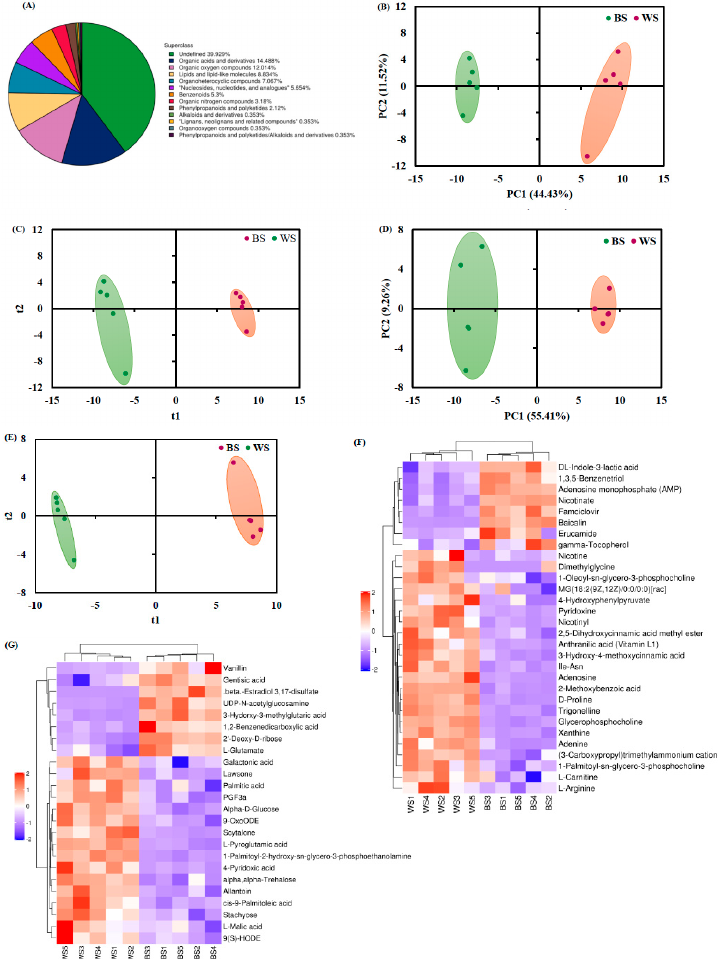
Figure 4. ( A ) Classification of metabolites identified in black and white sesames. ( B ) PCA score plot on the metabolites identified under ESI (+) mode. ( C ) PLS-DA score plot performed on the metabolites identified under ESI (+) mode (R 2 X = 0.55, R 2 Y = 0.99 and Q 2 = 0.98). ( D ) PCA score plot performed on the metabolites identified under ESI ( − ) mode. ( E ) PLS-DA score plot performed on the metabolites identified under ESI ( − ) mode (R 2 X = 0.62, R 2 Y = 0.99, and Q 2 = 0.98). ( F ) Heatmap of significantly different metabolites detected under ESI (+) mode between the two types of sesame seeds. ( G ) Heatmap of significantly varied metabolites identified under ESI ( − ) mode between the two types of sesame seeds. The differential metabolites were screened out, relying on the cutoff criteria of adjusted p value < 0.05 and VIP score > 1. Red color demonstrates significantly upregulated levels of metabolites, whereas the blue color demonstrates significantly downregulated levels of metabolites. BS, black sesame seeds; WS, white sesame seeds; VIP, variable importance in projection.